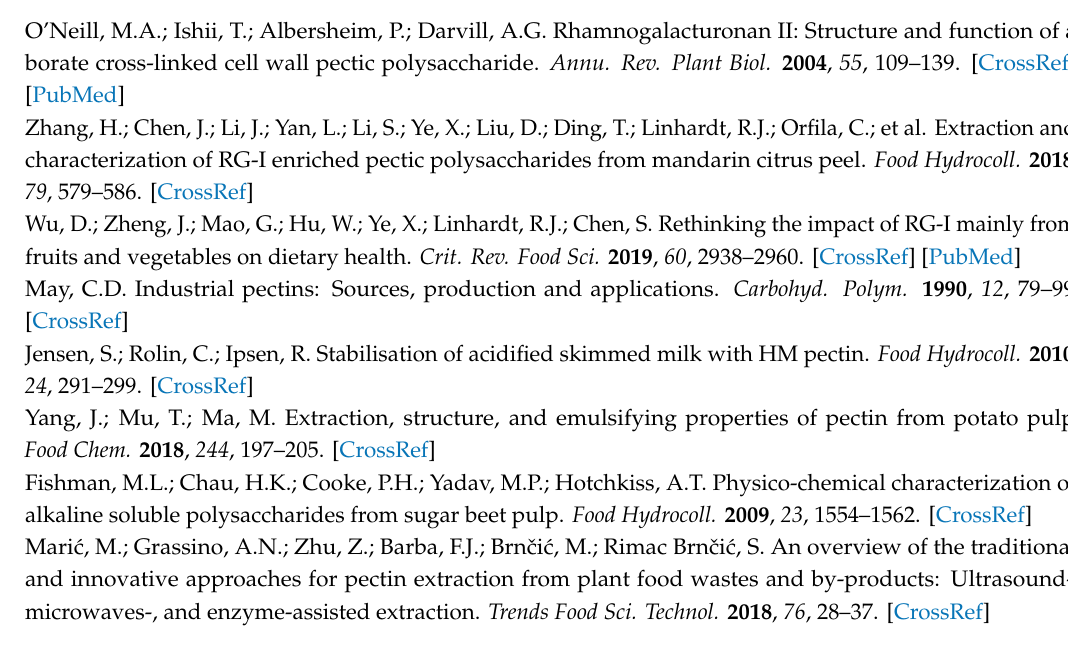
Supplementary Materials: The following are available online. Figure S1: Zeta potential of PPP, HMP and LMP (0.1%, w / v ) as a function of